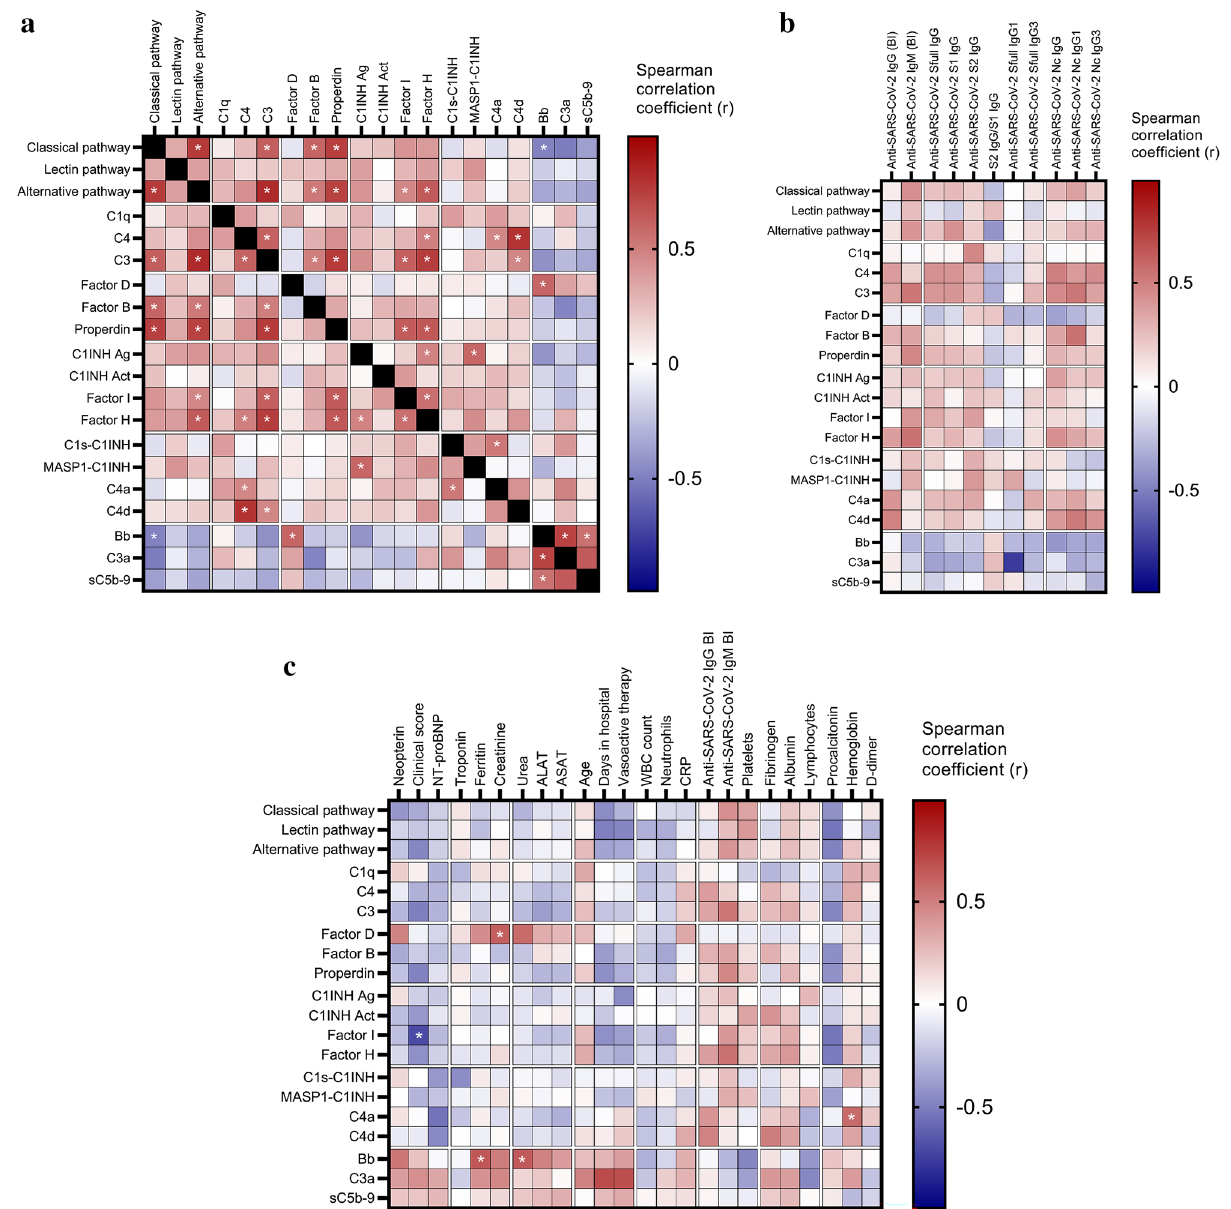
Figure 4. Associations between complement markers, clinical, laboratory and anti-SARS-CoV-2 humoral immune response features in the MIS-C cohort. Heatmap of correlation matrix of complement markers (Panel ( a ), complement markers and clinical and laboratory features (Panel b ), complement markers and SARS- CoV-2 humoral immune response measures (Panel c ). Color-coding indicates the strength of each correlation (Spearman correlation coefficients) with asterisks indicating significance (* indicate on Panel ( a ) p < 0.007, on Panel ( c ) p < 0.005 significant results, the limit was obtained after 5% false discovery rate correction using the Benjamini–Hochberg